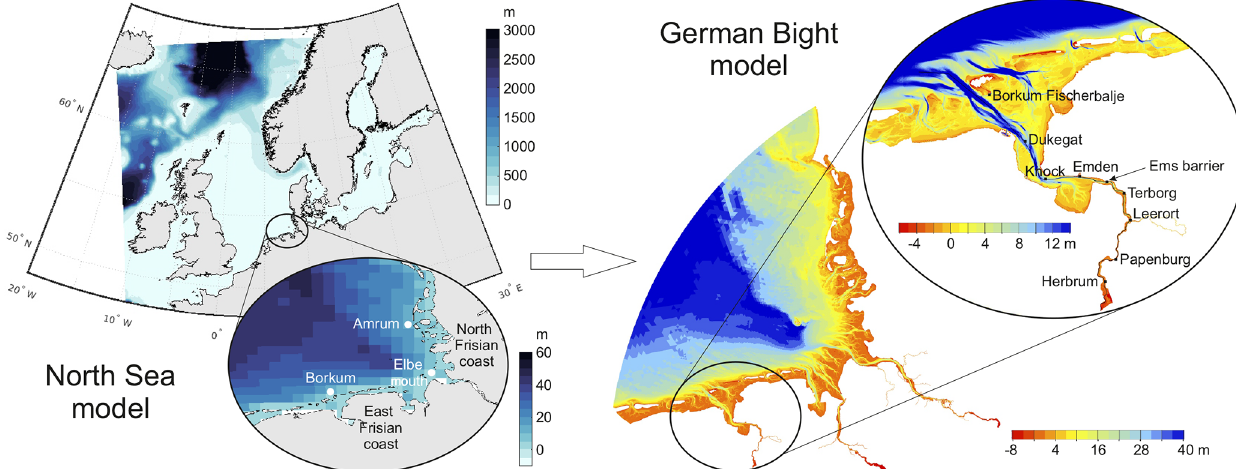
Figure 1. Model domains for the North Sea and German Bight models with distributions of water depths and enlargements of the German Bight and the Ems estuary, respectively. The black line in the enlargement of the Ems estuary denotes the longitudinal profile for which the highest high waters were